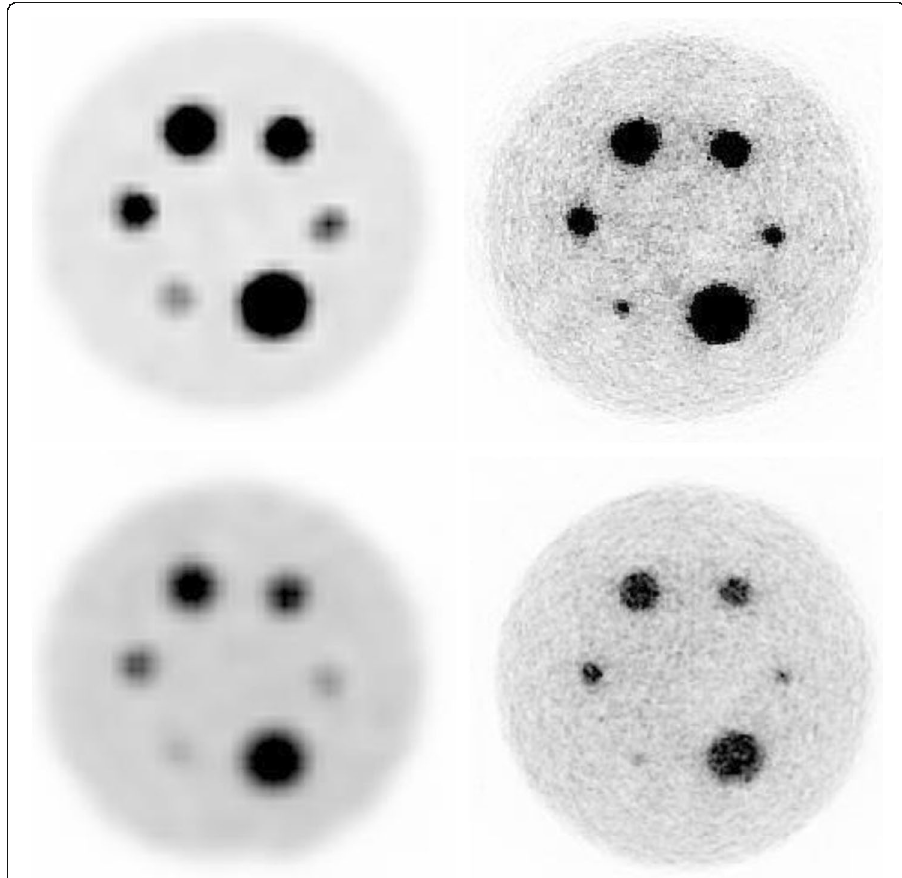
Fig. 13 Top, QP with insert-to-background ratio of 38 acquired and reconstructed in the Gemini-TF (left) and with the ProsPET system (1 mm voxel, 8 iterations, attenuation based on CT image, no scatter correction). Bottom, same as top but for an insert-to-background ratio of